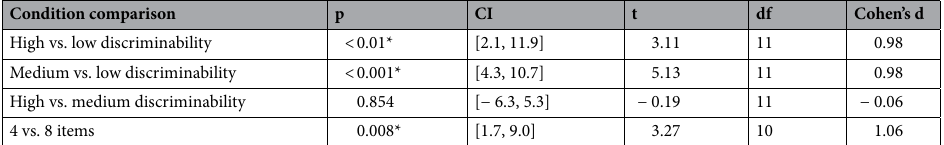
Table 2. Performance comparisons (2-by-2 t-tests) between experimental conditions. *Significant p values. CI: 95% Confidence Interval. df: degrees of freedom.